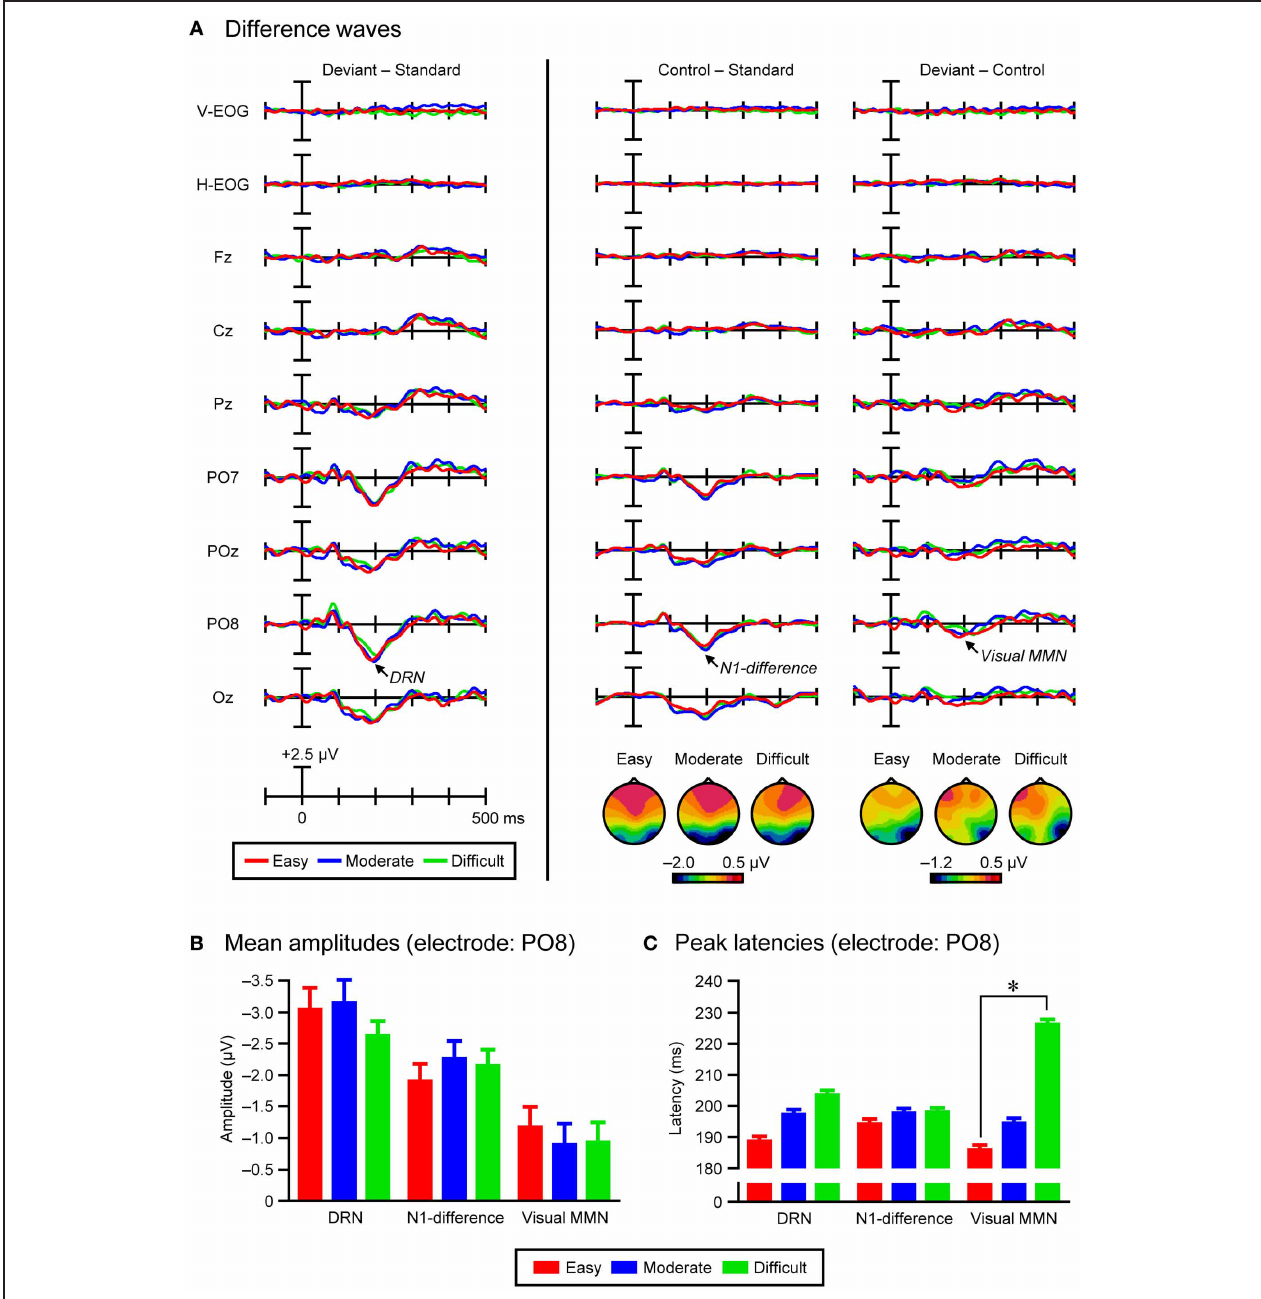
and visual MMN in the three task-difficulty conditions (electrode: PO8). Error bars indicate standard errors of the mean. (C) Grand-average peak latencies of DRN, N1-difference, and visual MMN in the three task-difficulty conditions (electrode: PO8). Error bars indicate standard errors of the mean with a jackknife method. Asterisks indicate a significant difference ( p < 0 .